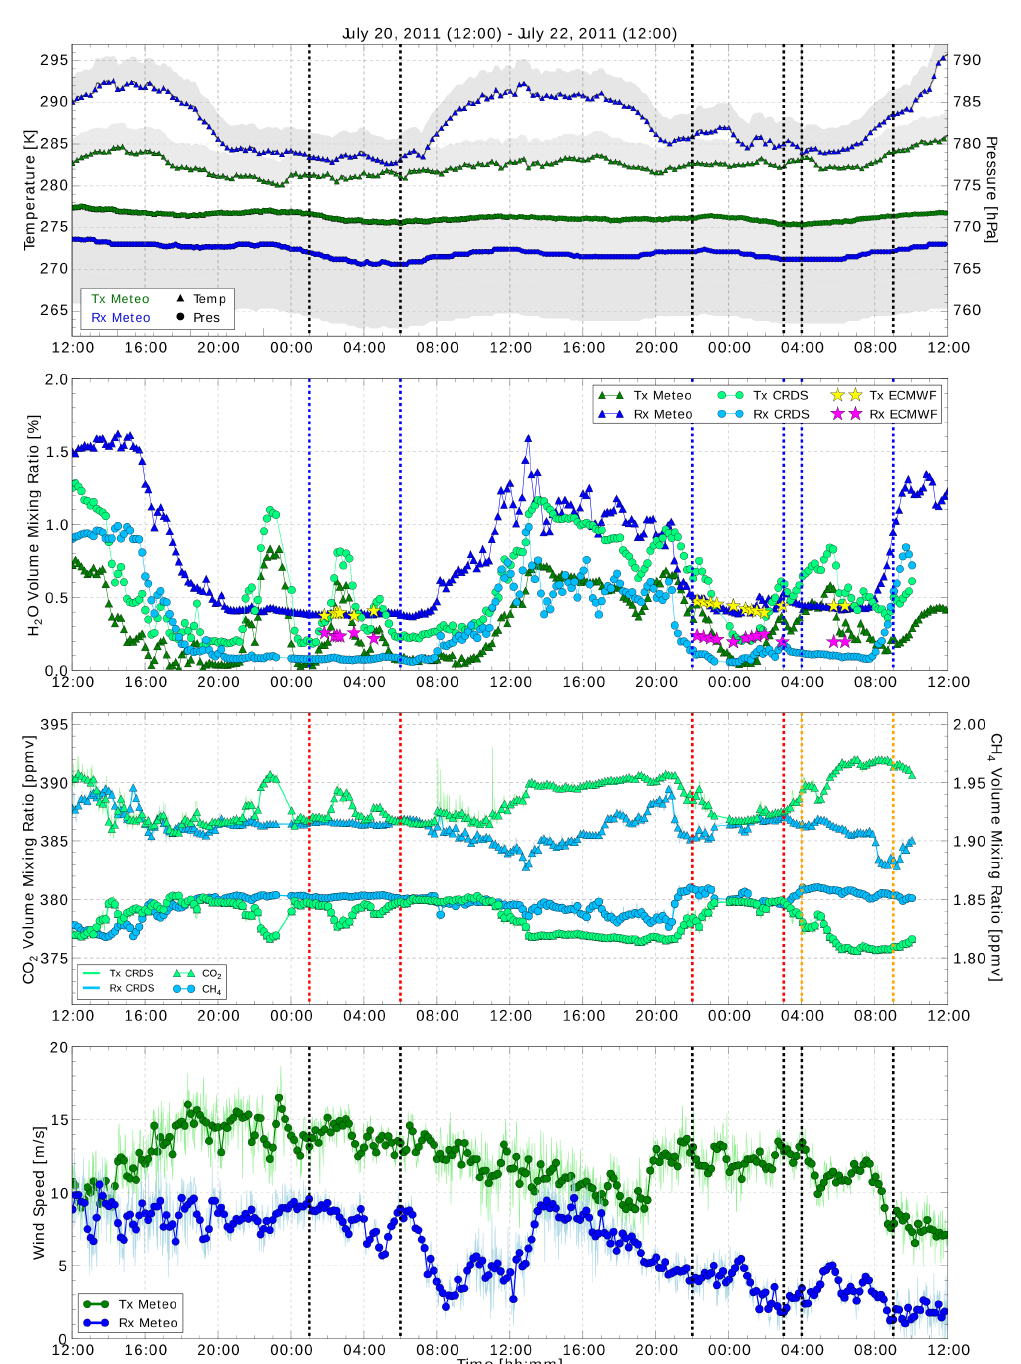
Figure 2. Time series of meteorological weather data and GHG validation data spanning the infrared-laser link measurements periods, which are delimited by dotted vertical lines (cf. times in Table 2). Top panel: 10min averaged temperature (triangles) and pressure (circles) data from the weather stations at the Tx (green) and Rx (blue) sites; the gray-shaded areas indicate the respective deviations of the co-located ECMWF data at the Tx and Rx sites. Upper-middle panel: 10min averaged H 2 O volume mixing ratio ( V ) from the meteorological weather stations (triangles), the CRDS instruments (circles), and co-located ECMWF data (stars; those interpolated to infrared-laser link measurement times) at the Tx and Rx sites. Lower-middle panel: 10min averaged CRDS V data for CO 2 (triangles) and CH 4 (circles) at the Tx and Rx sites. Bottom panel: 10min averaged wind speed (circles) and underlying 1min values (light-colored fluctuating time series), from the weather stations at the Tx (green) and Rx (blue)